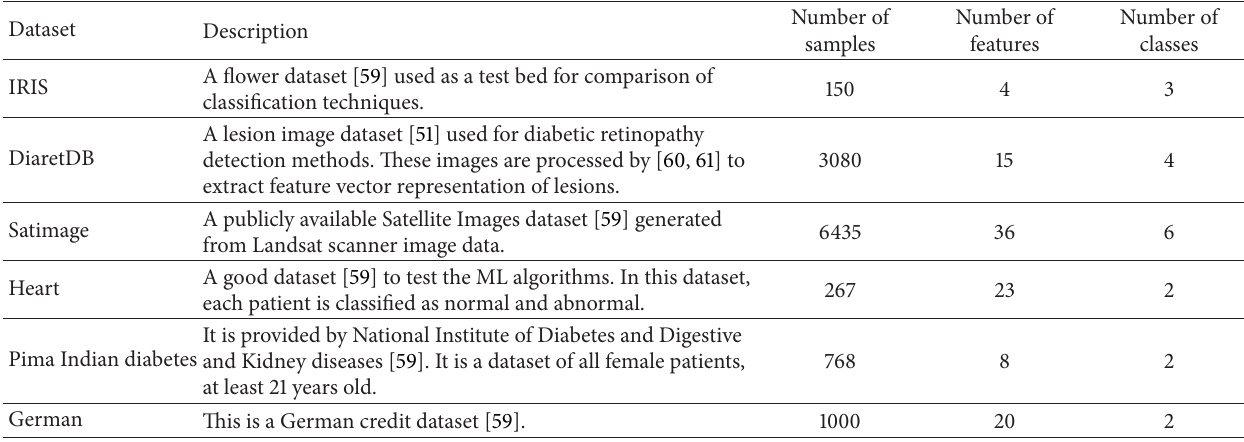
Table 1: Overview of datasets used for experimental evaluation.